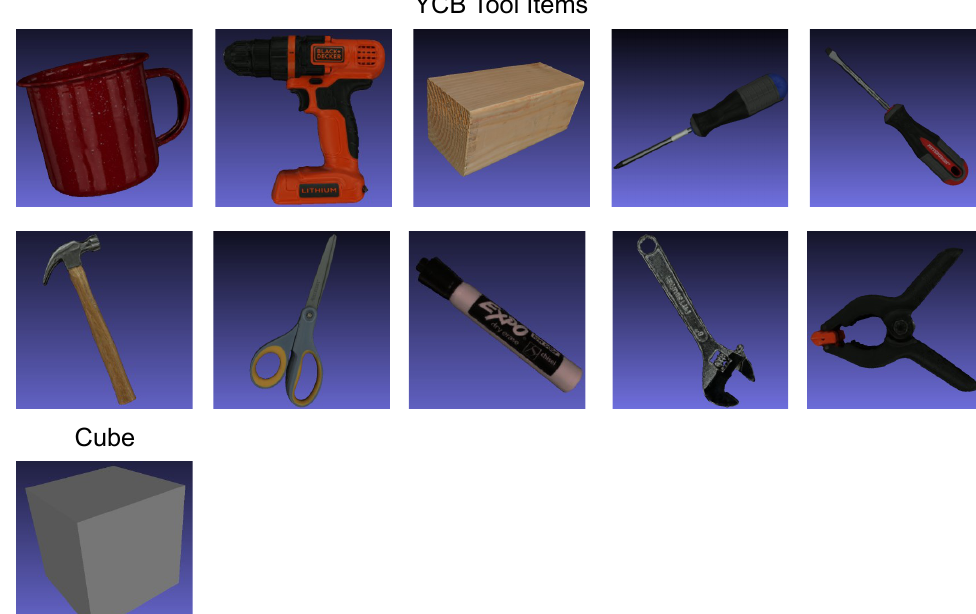
Figure 8. Ten realistic YCB tool items [50] are used as additional foreground objects and compared to a simple